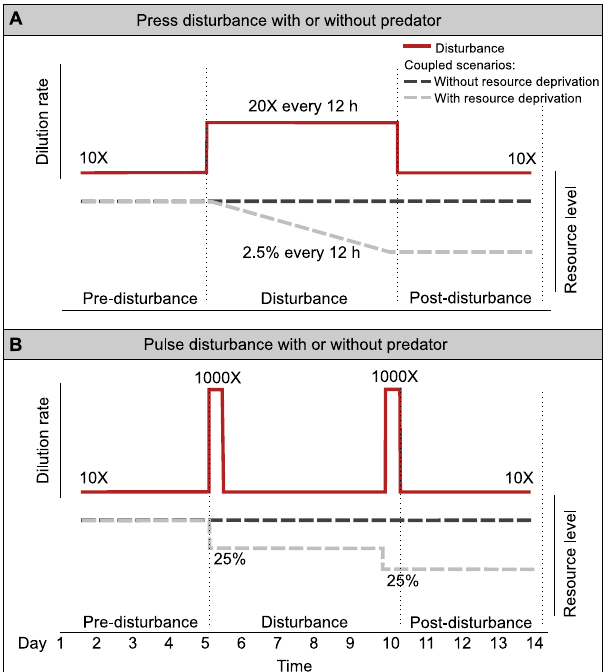
Figure 1. Experimental design. ( A ) Press disturbance with or without the predator. ( B ) Pulse disturbance with or without the predator. Dilution factors indicate the strength of simulated mortality and resource levels indicate the degree of resource deprivation: For press disturbance 2.5% reduction steps with 20-fold community dilution at each step, and, for pulse disturbance, 25% reduction steps with 1,000-fold community dilution at each step was applied. Vertical dashed lines delimit the three phases and indicate the times of